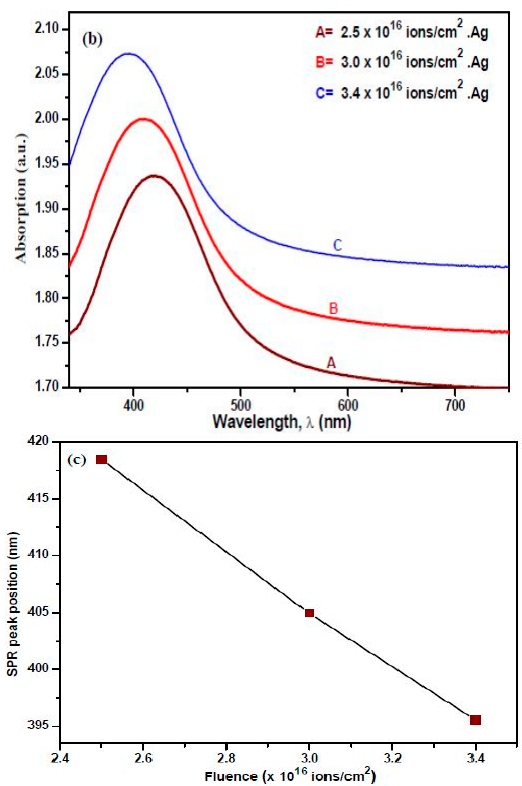
Figure 5. ( a ) Optical absorption spectra for pristine a-C, ( b ) combined spectra for Ag:a-C nanocomposites and ( c ) dependence of surface plasmon resonance (SPR) peak position on fluence of irradiation.